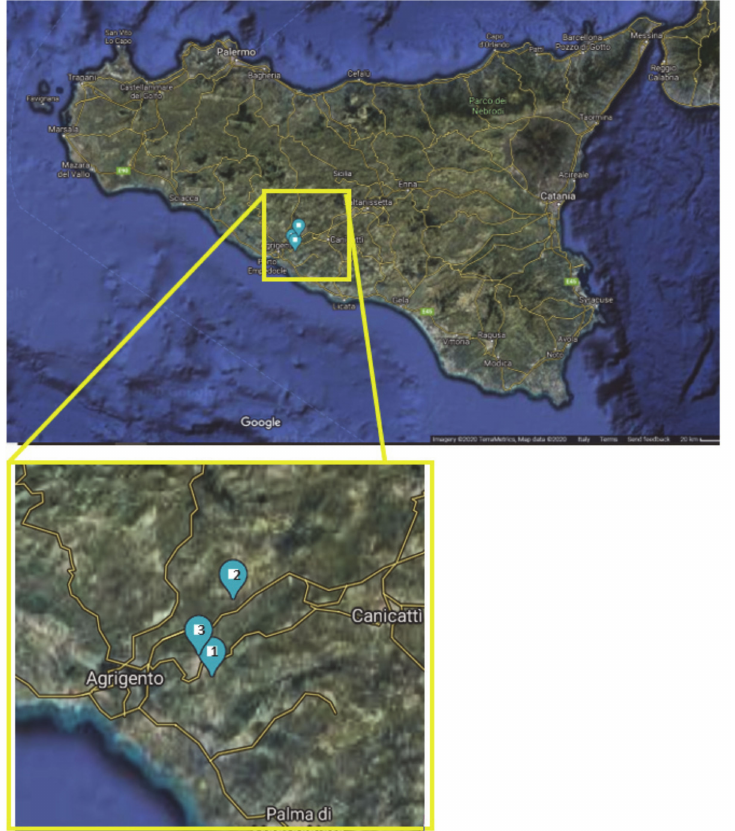
Figure 1. Geographical positions of the three studied Origanum fields. 1: Favara (AG), 37 ◦ 18 (cid:48) 38.8" N, 13 ◦ 40 (cid:48) 26.1” E; 2: Racalmuto (AG), 37 ◦ 22 (cid:48) 15.5” N, 13 ◦ 41 (cid:48) 40.7” E; 3: Agrigento (AG), 37 ◦ 19 (cid:48) 37.1” N, 13 ◦ 39 (cid:48) 35.2”